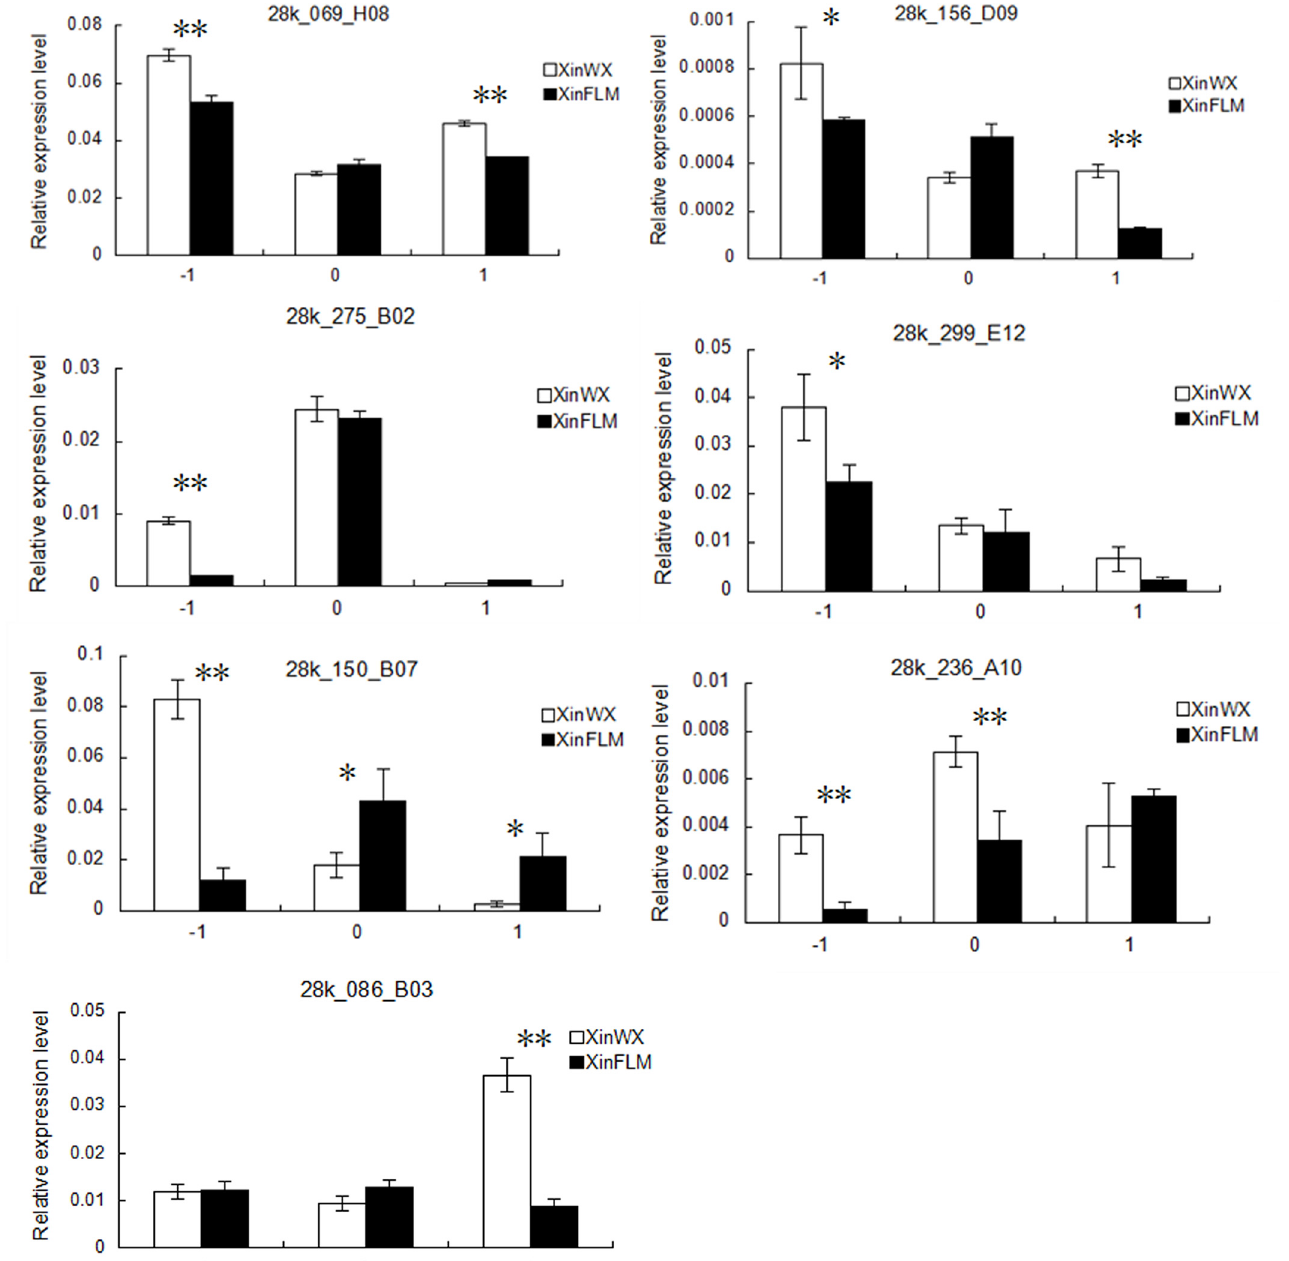
Fig 8. Differentially expressed genes involved in JA biosynthesis and signal transduction. Mixtures of ovules and fibers at -1, 0, and 1 DPA are shown in x-axis. Error bars indicate ± SD. Significant differences at the 0.05 and 0.01 probability levels are represented by * and ** , respectively. The expression level was derived from triplicate experiments. Three biological replicates were used for